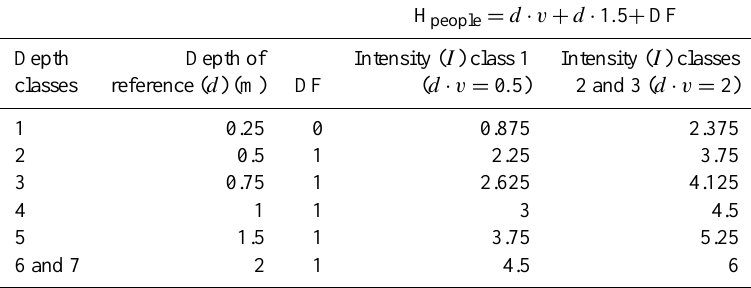
Table 7. Hazard scores for people computed from available data (water depth – d , velocity – v , debris factor – DF, and intensity – I ).